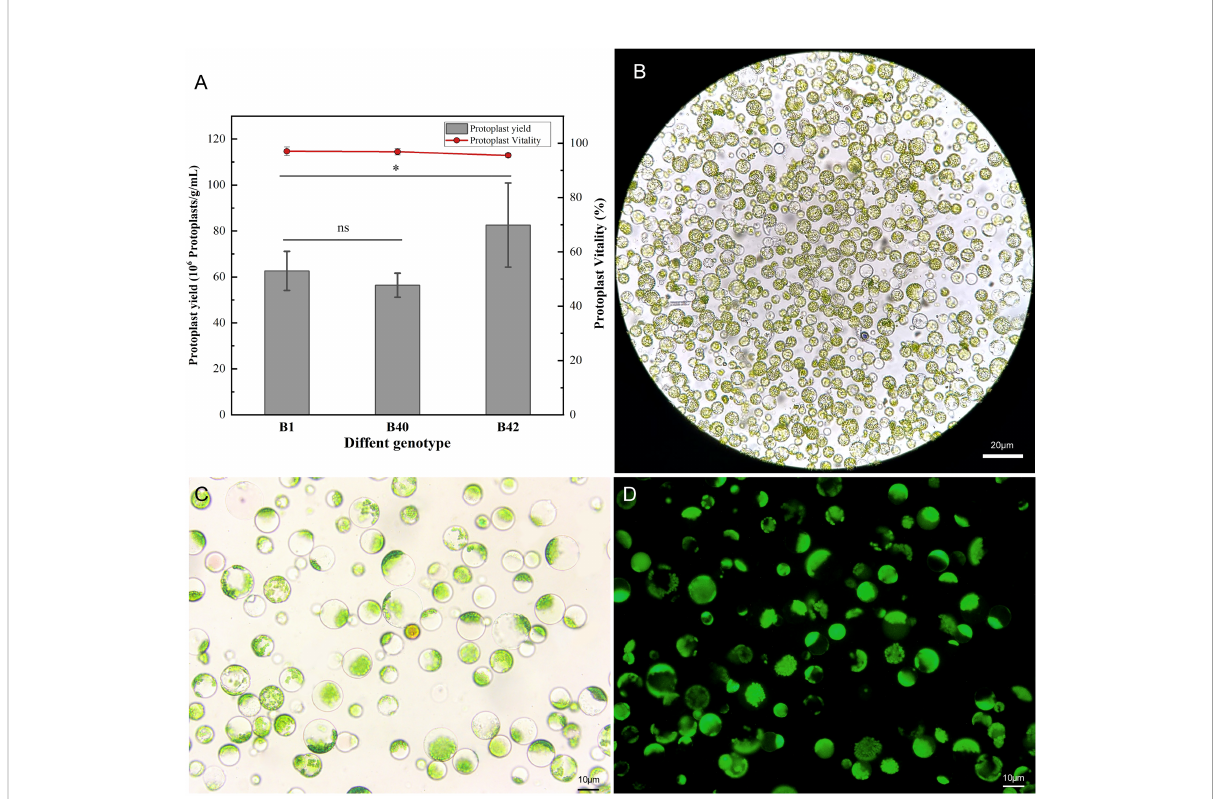
FIGURE 1 Yield and viability of cotyledon protoplasts of different broccoli genotypes. (A) Statistics on cotyledon protoplast yield and viability of three genotypes of broccoli, B1, B40 and B42. Data represent the means of 3 values, and error bars show the standard error values; Statistical signi fi cance levels (Student ’ s t-test) are shown: ns, no signi fi cant; * p < 0.05. (B) Microscopic examination of B1 genotype protoplast, scale bar = 20 m m. (C) The bright fi eld images of B1 genotype protoplast for fl uorescein diacetate (FDA) microplate assay, scale bar = 10 m m. (D) The dark fi eld images of